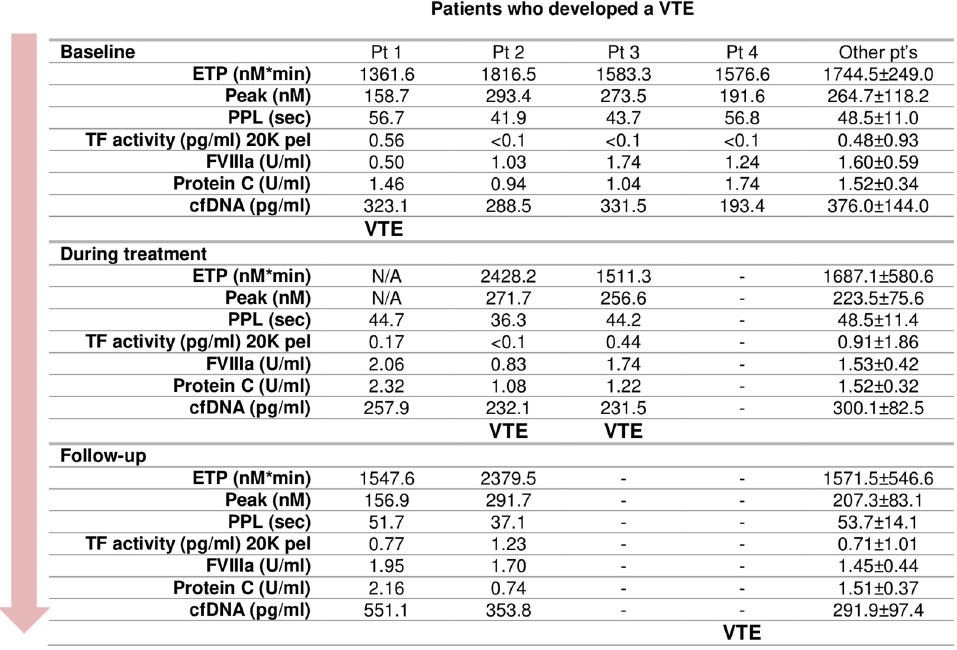
Fig 3. Coagulation profile of SCLC patients who developed a VTE during the study period compared to all other patients. Data is presented as mean ± SD where applicable. Patients 3 and 4 did not donate all blood samples and for P1, thrombin generation during treatment could not be assessed due to treatment with